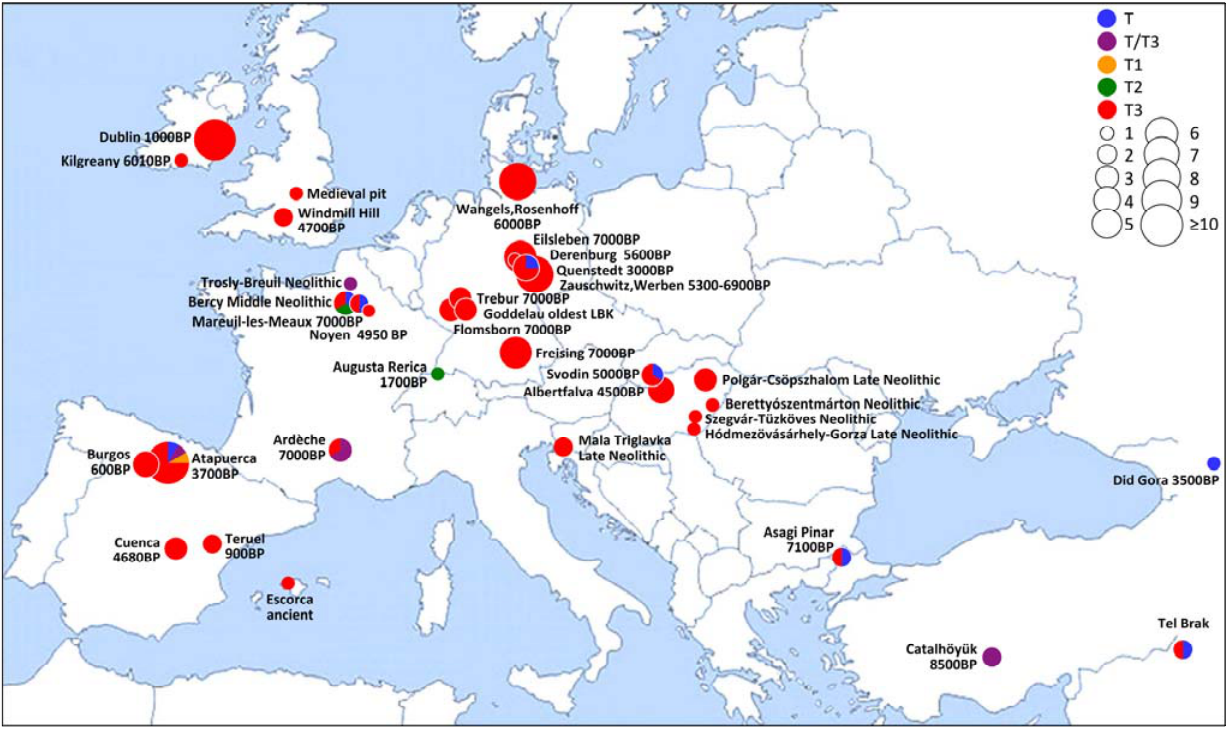
Figure 2. Mitochondrial DNA (MtDNA) haplogroup distributions in European and Southwest-Asian ancient DNA samples from domestic cattle. Data are from